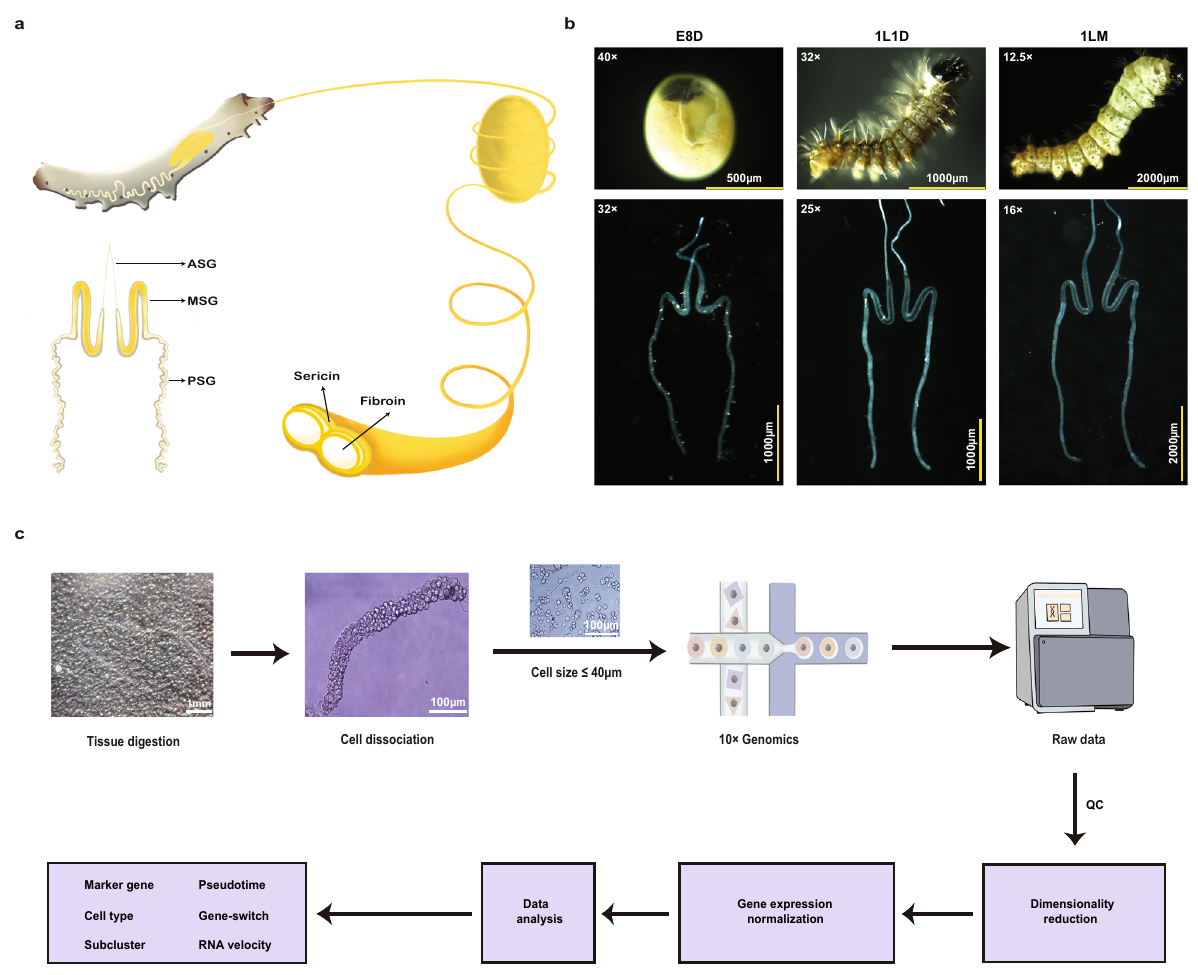
Fig. 1 Work fl ow of the scRNA-seq analysis of silkworm silk glands. a Schematic diagram of the silkworm larva, silk gland, and cocoon silk. The anterior silk gland (ASG) is a processing lumen of liquid silk protein, the middle silk gland (MSG) is responsible for producing silk sericin protein, and the posterior silk gland (PSG) is responsible for producing silk fi broin protein. b Silk glands at three developmental stages used for the scRNA-seq analysis. Images show the developing embryo and larvae and corresponding silk glands. E8D, 8 days post-egg laying; 1L1D, day 1 of the fi rst instar; 1LM, the fi rst larval molting. c Schematic diagram of sample preparation and work fl ow of data